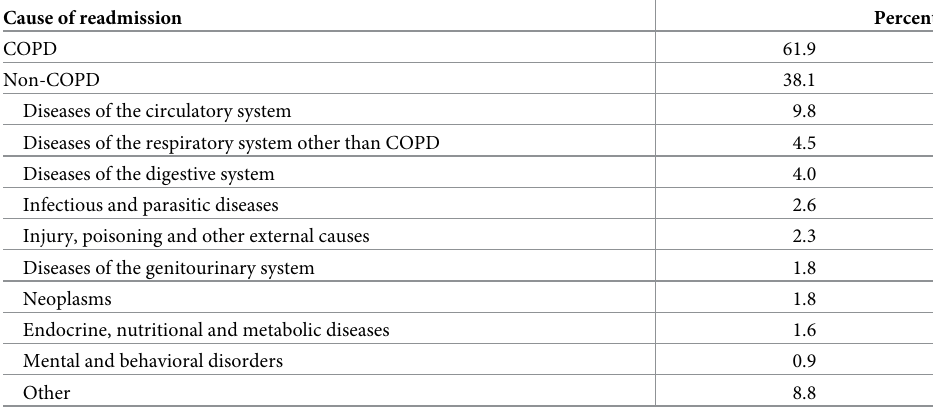
Table 2. Causes of 30-day readmission among patients with a COPD hospitalization.